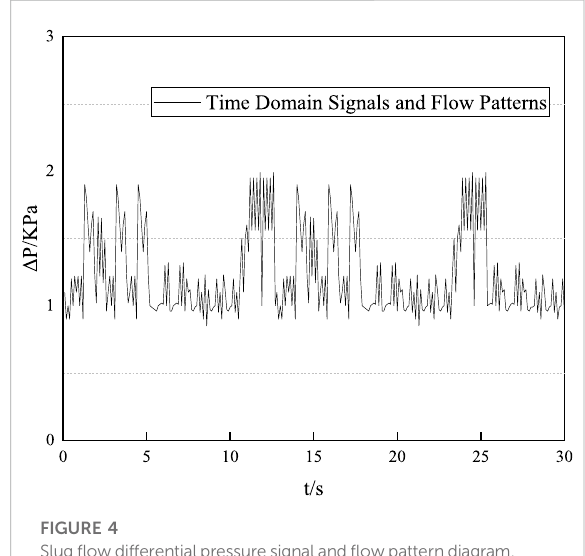
FIGURE 4 Slug fl owdifferentialpressuresignaland fl